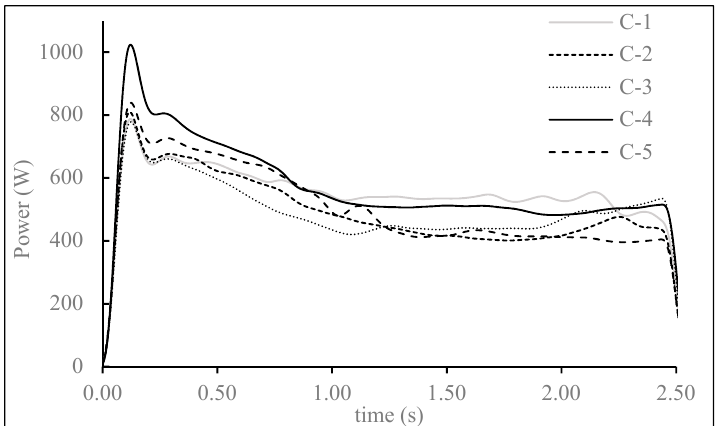
Figure 11. The time traces of the weld power for the controlled weld cases (the plotted curves are for the weld spots whose temperature curves are plotted as the dotted line in Figure 10).